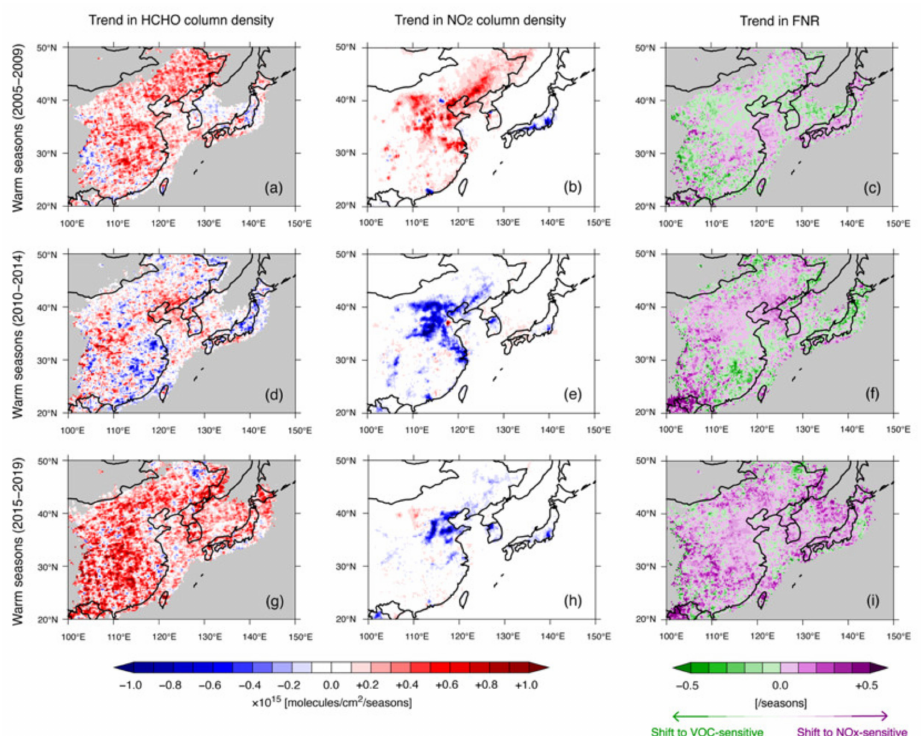
Figure A2. Linear regression analyses for ( a , d , g ) HCHO column density, ( b , e , h ) NO 2 column density, and ( c , f , i ) FNR over East Asia during the 5-year periods of ( a – c ) 2005–2009, ( d – f ) 2010–2014, and ( g – i ) 2015–2019 averaged over the warm seasons. HCHO column density and FNR are analyzed at grid points where NO 2 column density is greater than 1.0 × 10 15 molecules cm − 2 .